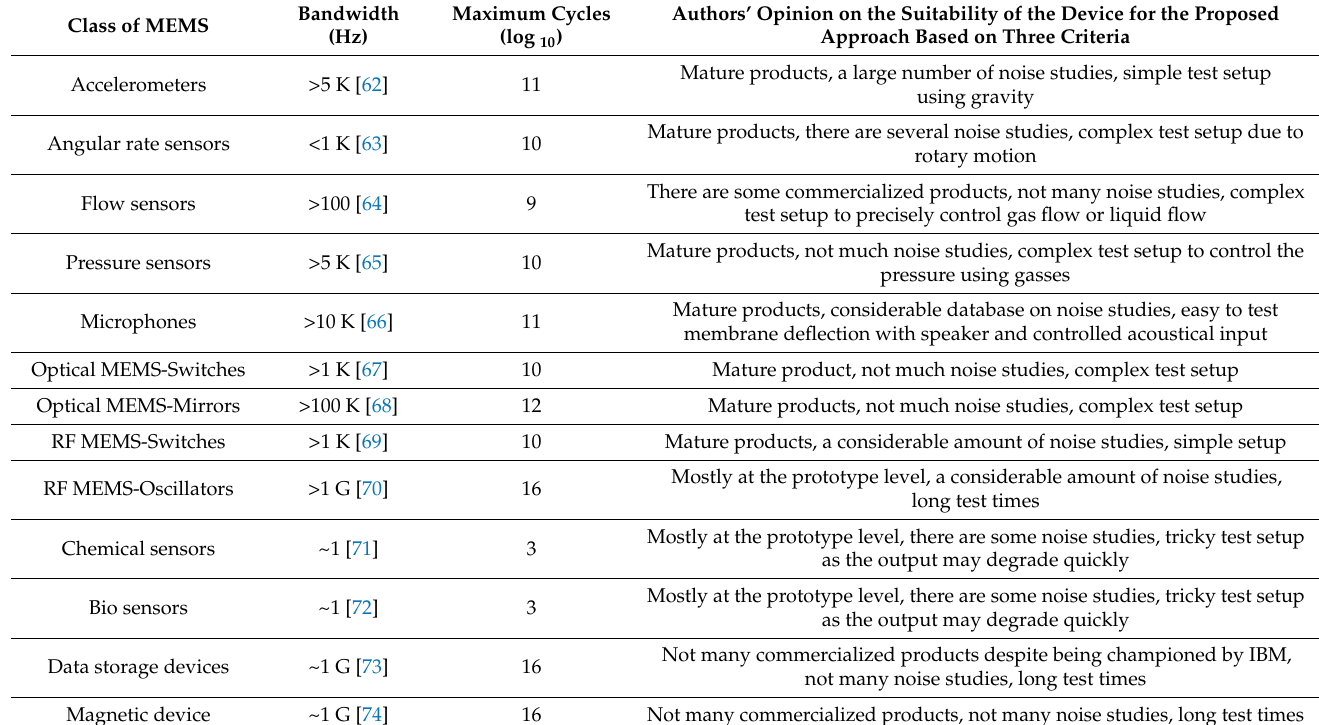
Table 2. Classes of MEMS devices, their bandwidth (BW), estimated number of cycles they experience during full-time use at maximum bandwidth for one year, and authors’ opinion on the suitability of each class for the proposed approach. Bandwidth Maximum Cycles Authors’ Opinion on the Suitability of the Device for the Proposed Class of MEMS (Hz) (log 10 ) Approach Based on Three Criteria Accelerometers